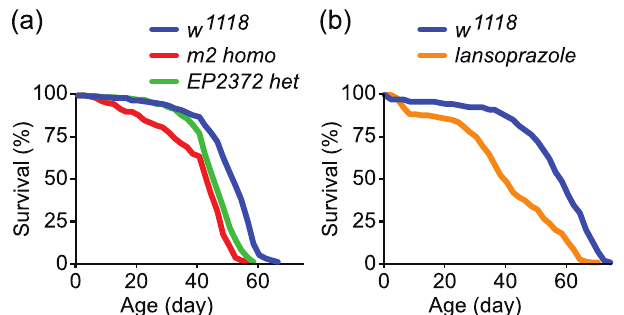
Fig 4. Midgut acid suppression shortens life span in flies. (a) Shortened life spans in m2 homozygous mutant flies (red) and EP2372 heterozygous mutant flies (green) compared to control flies ( w 1118 , blue). (b) Shortened life spans in lansoprazole-treated flies (orange) compared to control flies ( w 1118 , blue). Statistical analysis is shown in Table